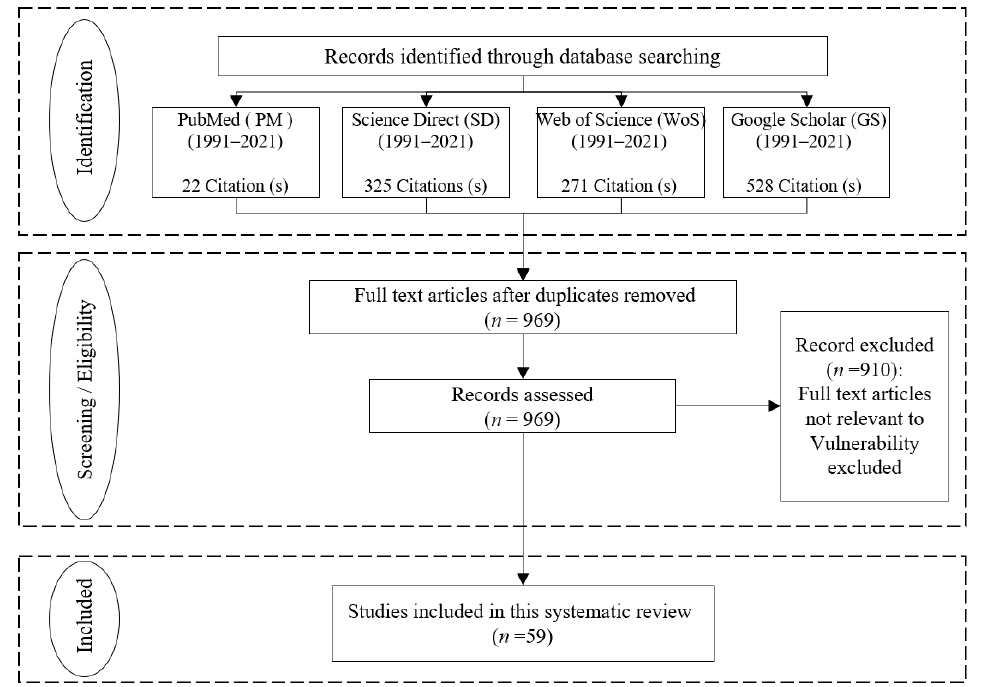
Figure 2. Adapted PRISMA (Preferred Reporting of Items for Systematic Review and Meta-Analysis). Note: Different phases in retrieving the published papers from the four comprehensive databases about vulnerability analysis in the Himalayan region (modified from Moher et al. [63]).